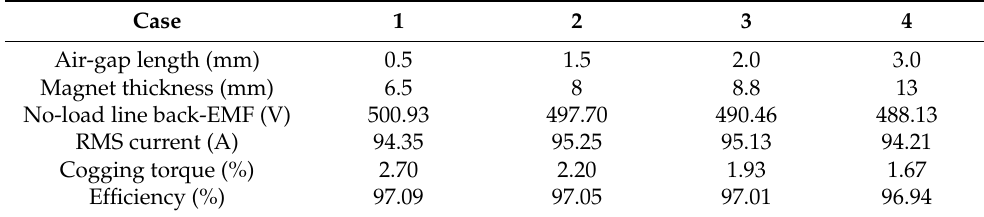
Table 2. Electromagnetic characteristics under different air-gap